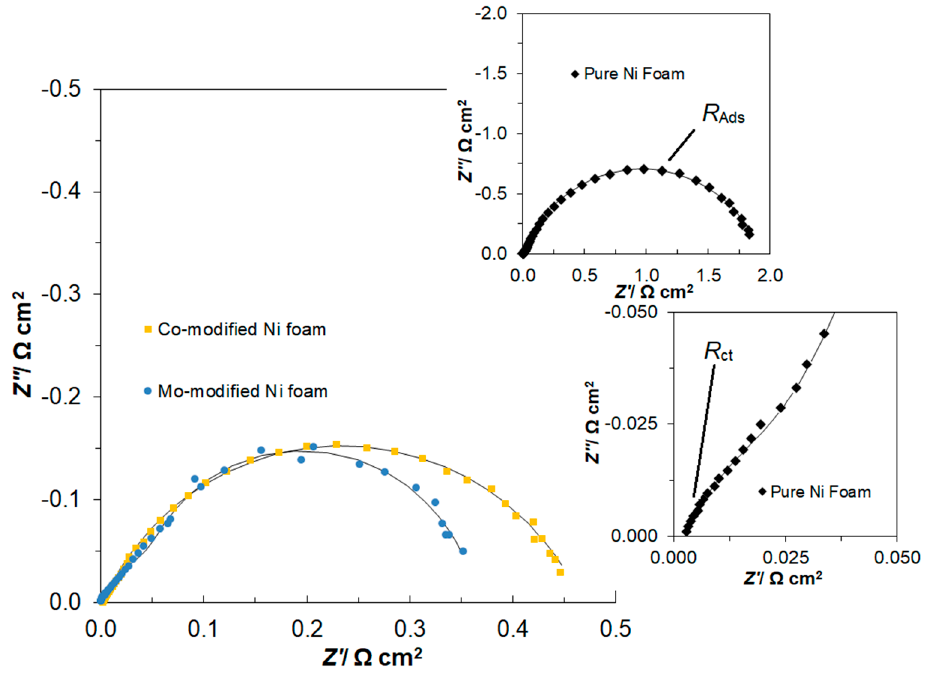
Figure 4. Electrochemical impedance Nyquist plots for the OER on oxidized Ni foam, Co- and Mo-modified Ni foam electrode surfaces in contact with 0.1 M NaOH (at 20 °C) for the potential of 1.6 V vs. RHE. The solid line corresponds to representation of the data according to equivalent circuit presented in Figure 5 below.